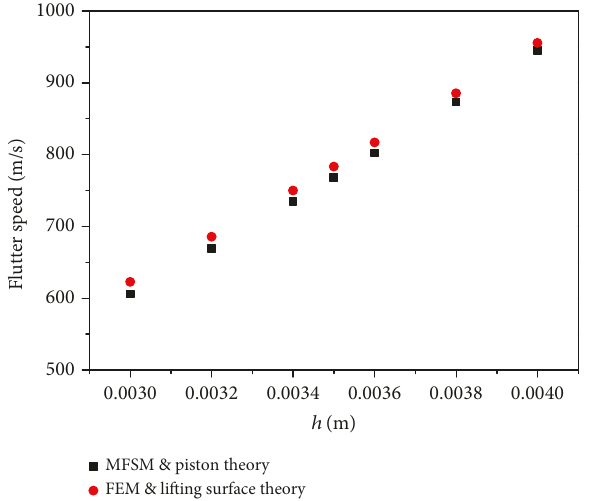
Figure 9: Flutter speeds of panels in di ff erent thicknesses with width b = 1 3